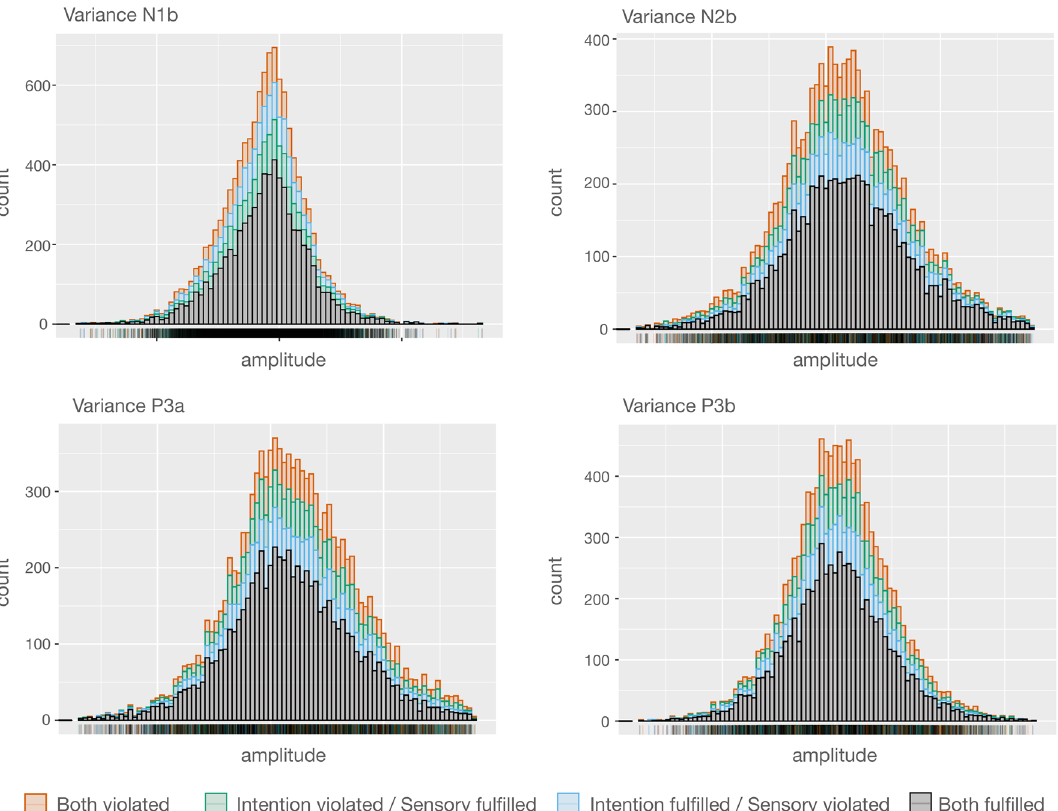
Figure 7. Distribution of amplitudes of each condition in stacked histograms for the four components where significant results were found. The Levene’s test confirmed that variances did not differ between conditions for each